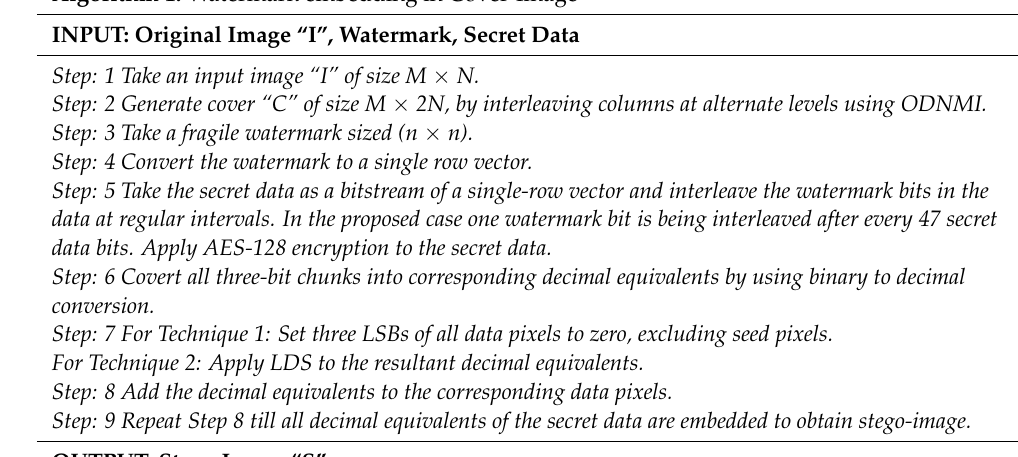
Algorithm 1: Watermark embedding in Cover-Image